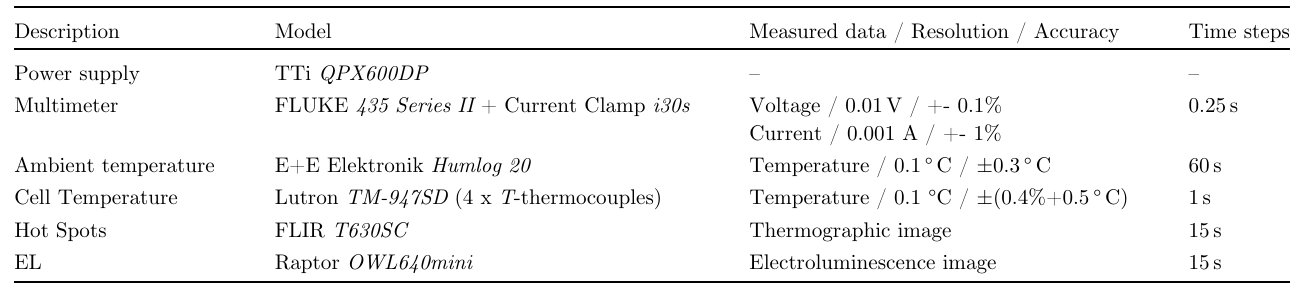
Table A.1. Speci fi cation of equipment and time stamps used for measurements performed as described in Section 2.